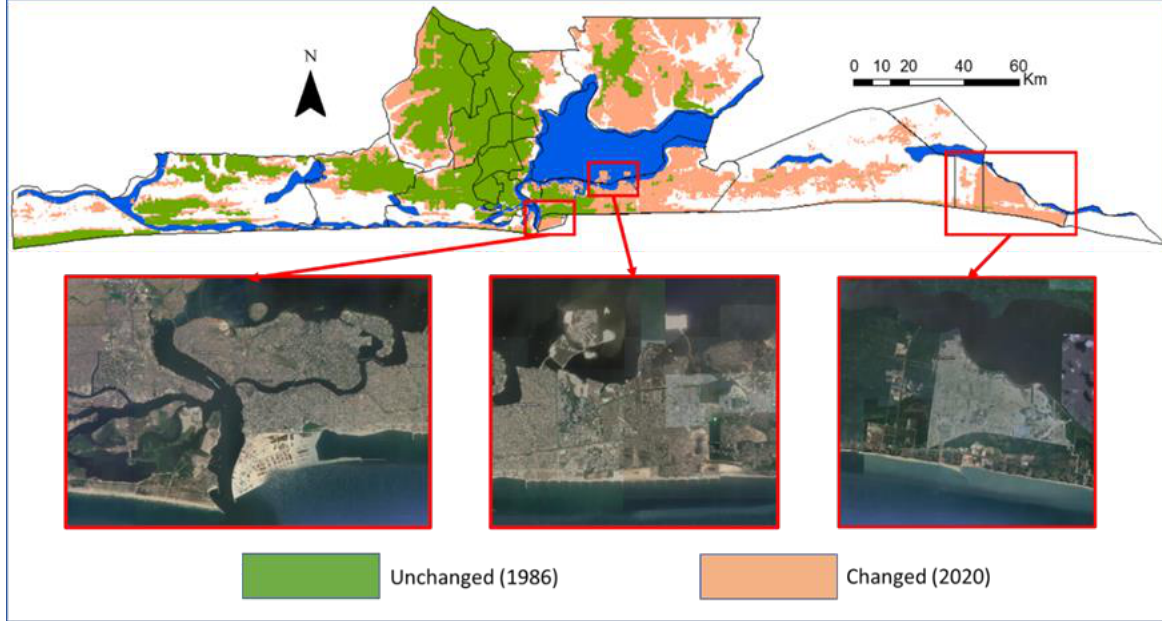
Figure 7. Land cover changes in comparison to Google Earth Images acquired in 2019 showing changes on the ground for the Eko Atlantic (left), two reclaimed islands through dredging (middle), and the Dangote refineries (right).